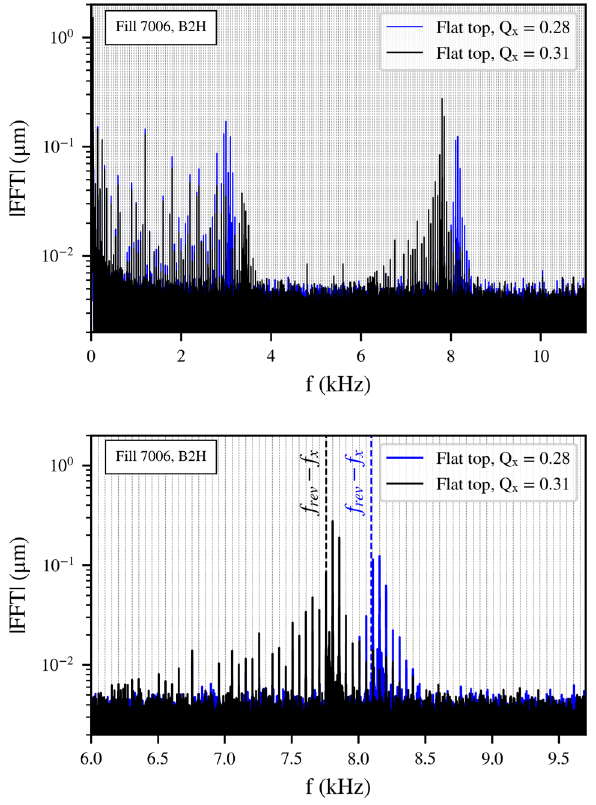
FIG. 11. The horizontal spectrum of Beam 2 prior (blue) and after (black) the tune change at flat top in a frequency range up to 10 kHz (top) and centered around the high-frequency cluster (bottom). The gray dashed lines represent the multiples of 50 Hz. The dashed blue and black vertical lines illustrate the location of f − f x . rev (cid:3) 20 degrees for the horizontal plane of Beam 1. During this time interval, the amplitude evolution of the harmonics is computed.